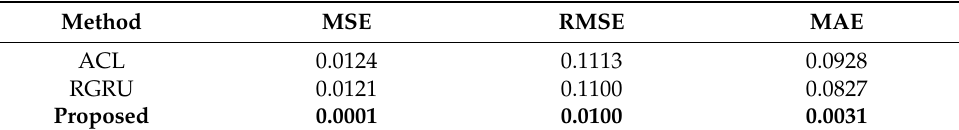
Table 4. Various models performance over the KAB dataset using hourly resolution data. Bold results demonstrate the best performance.